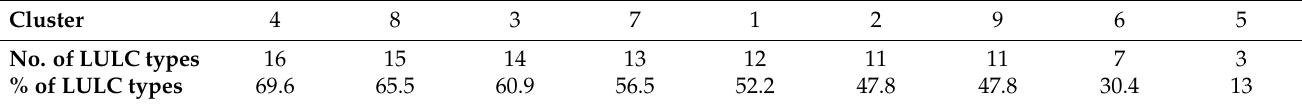
Figure 9. Cross tabulation of clusters and CORINE land-use/land-cover types.